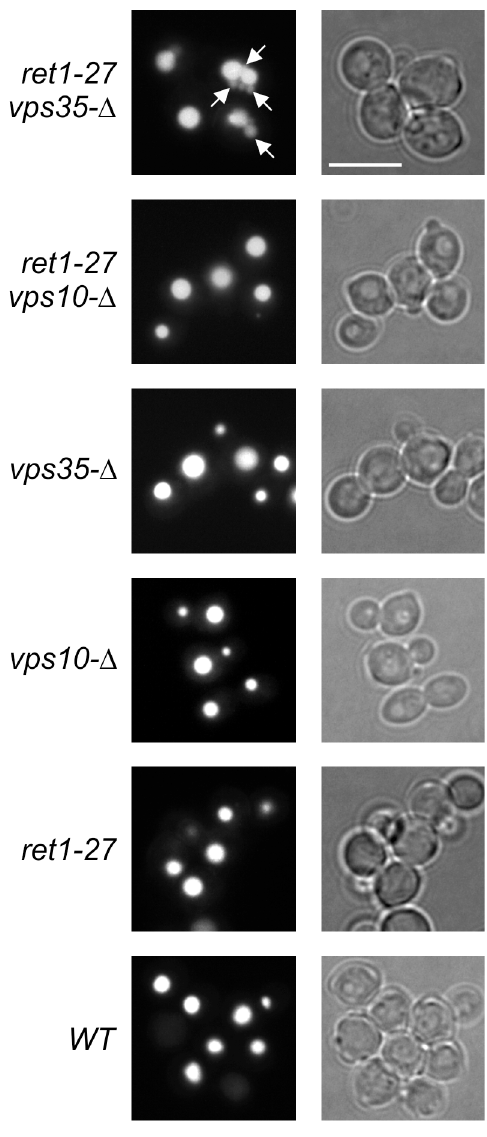
Fig 10. Cell Tracker Blue staining of vacuoles. ret1-27 vps35- Δ , the 64MA70UA- Δ vps35 strain; ret1-27 vps10- Δ , the 64MA70UA- Δ vps10 strain; vps35- Δ , the 64MA70U-RET- Δ vps35 strain; vps10- Δ , the 64MA70U-RET- Δ vps10 strain; ret1-27 , the 64MA70UAL strain; WT , the 64MA70UA-RET strain. The white bar corresponds to 5 μ m. Arrows indicate the additional compartments stained like the vacuole.